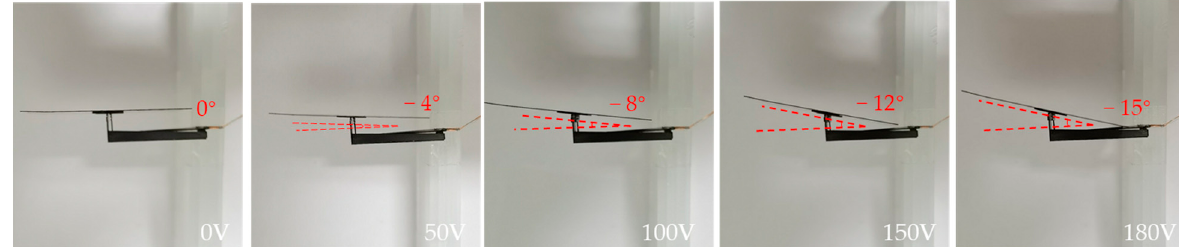
Figure 9. Reverse-biased drive test of deformed squama.